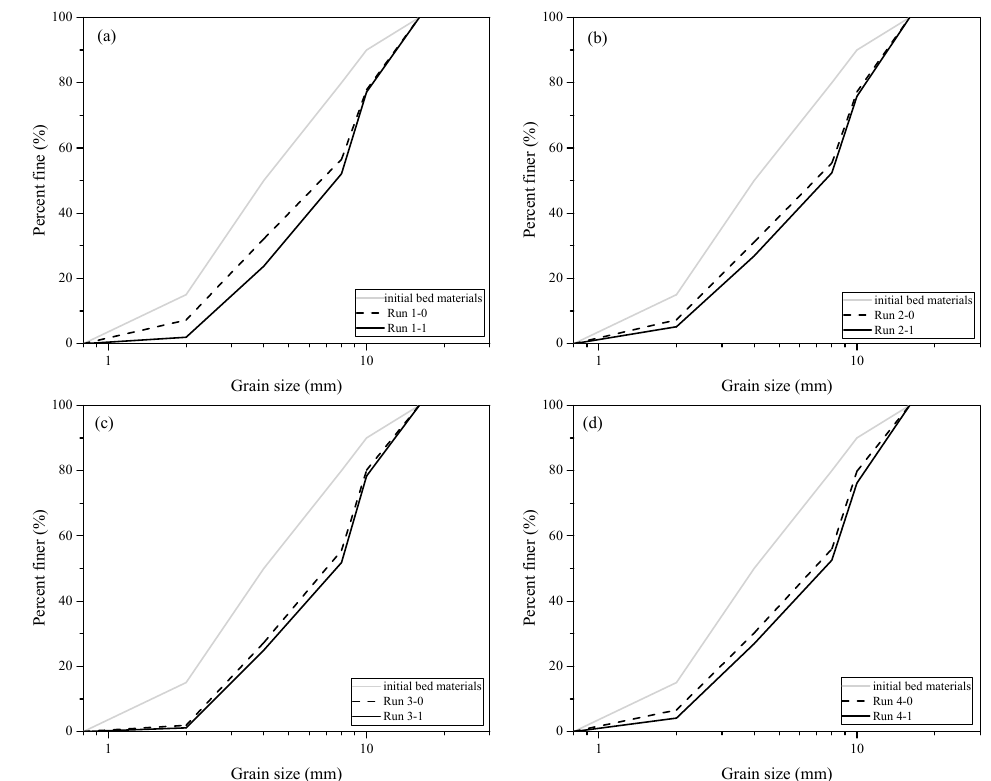
Figure 13. The grain size distribution of the armor layer: ( a ) Run 1; (b ) Run 2; ( c ) Run 3; and ( d ) Run 4.